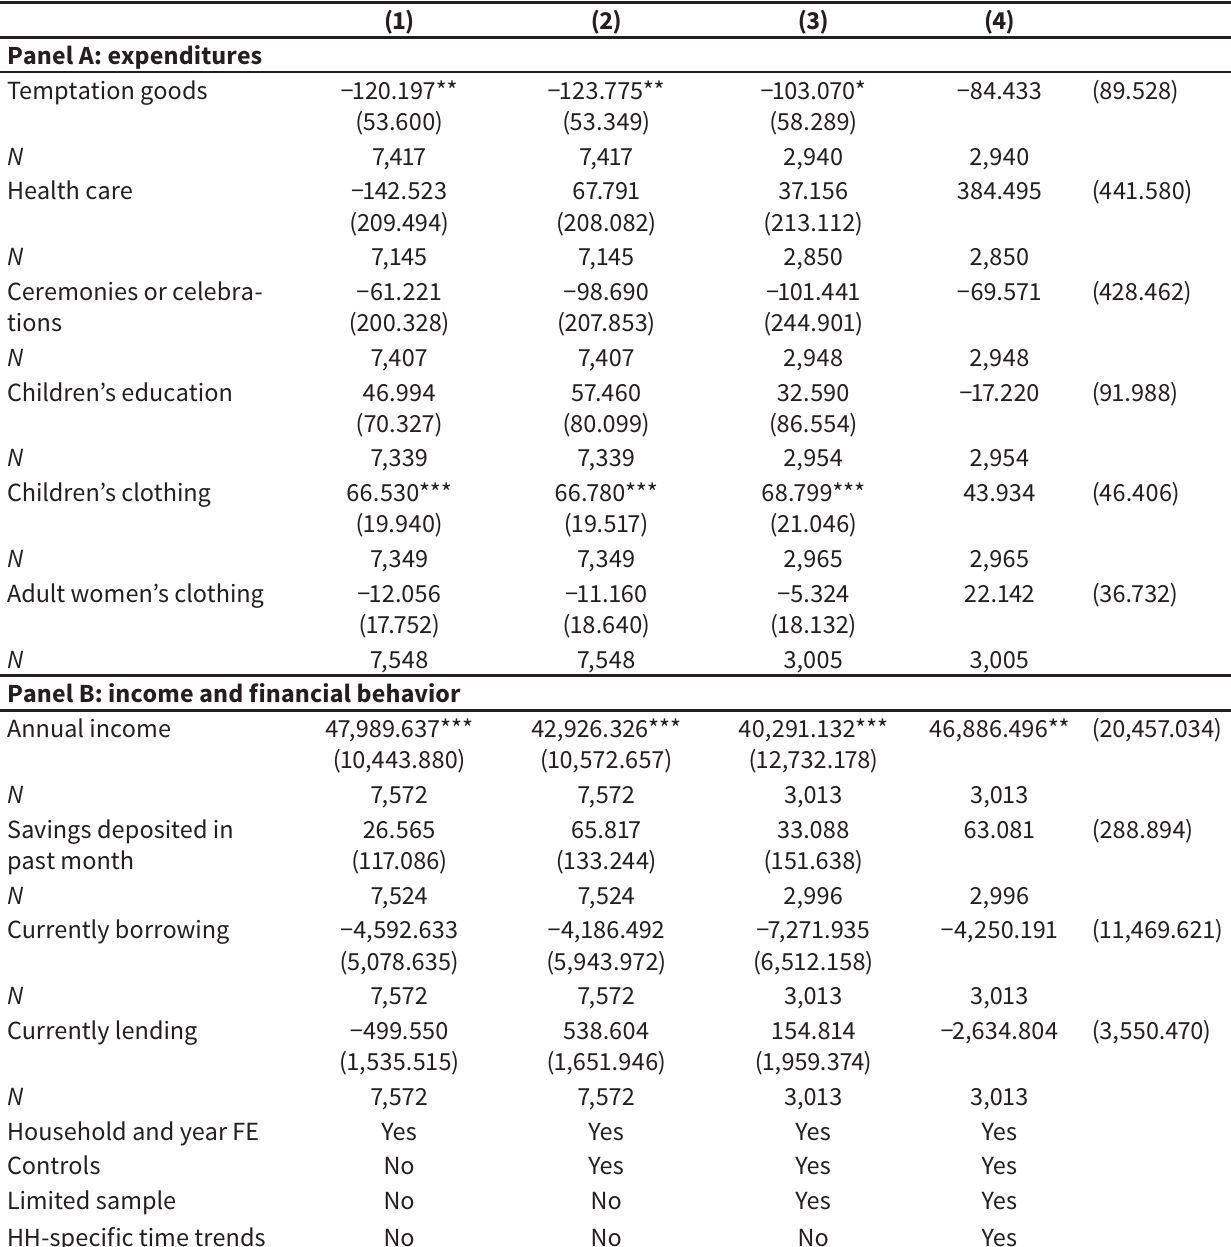
Changes in expenditures, income, and financial behavior as the husband’s migrant status changes – top-coded at the 99th